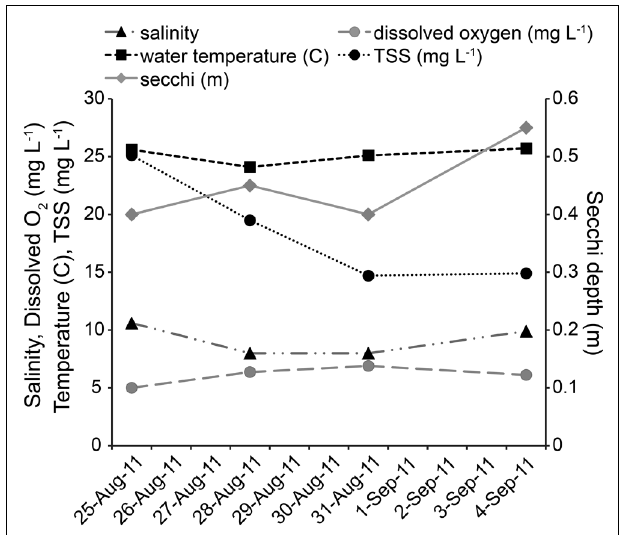
FIGURE 2 | Physical and chemical measurements of the environment.